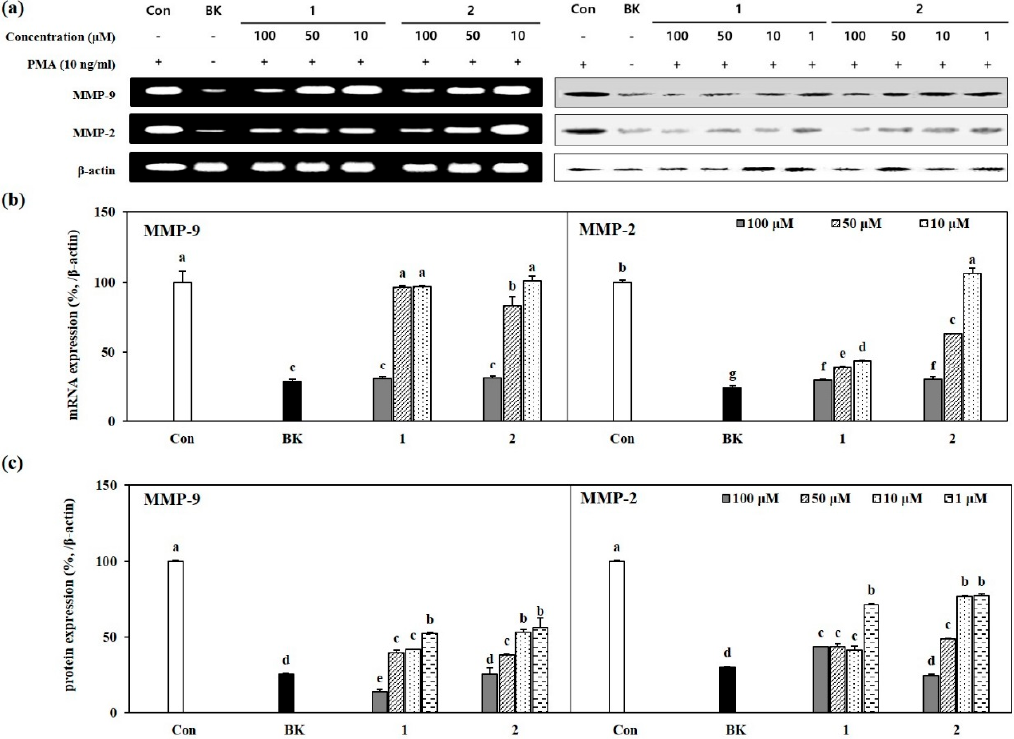
Figure 4. Effect of GL-3 ( 1 ) and oleonuezhenide ( 2 ) on the expression MMP-9 and MMP-2 mRNA and protein levels. ( a ) Cells were treated with indicated concentrations of compounds 1 and 2 prior to stimulation with PMA for 1 h and further incubated for 24 h. The expression levels of mRNA and proteins were detected on images of specific bands using RT-PCR and Western blotting, respectively. β -Actin was used as an internal standard. ( b , c ) Relative expression levels of MMP-9 and MMP-2 mRNA and proteins were given as percentage of stimulated untreated control cells (Con) after normalizing against internal control. Quantification of the bands was achieved by densiometric calculations. Values are mean ± SD of three independent experiments. a–g Means with different letters are significantly different at p < 0.05 level. (BK: untreated unstimulated cells).